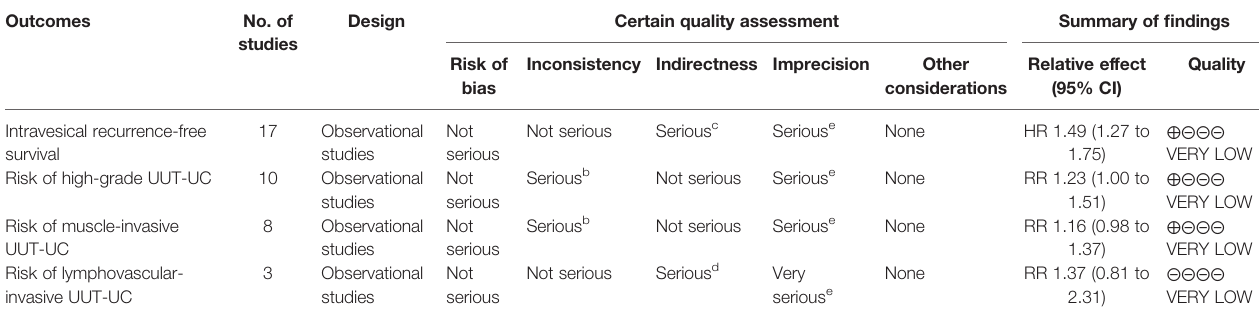
TABLE 6 | The overall quality of evidence in pooled fi ndings from eligible studies a